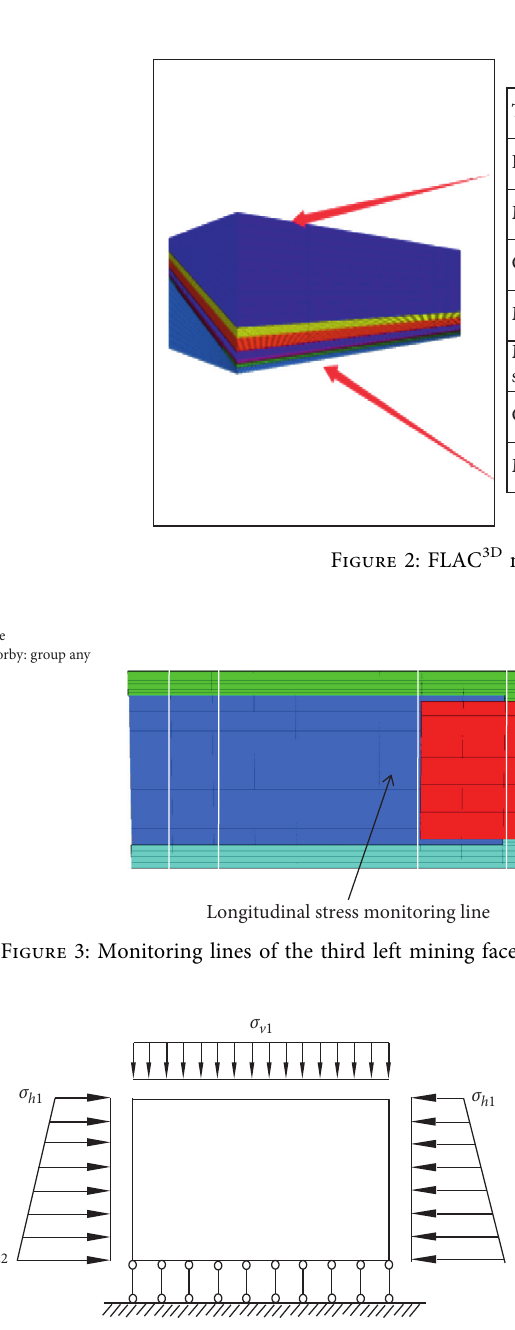
Figure 4: Boundary conditions of the